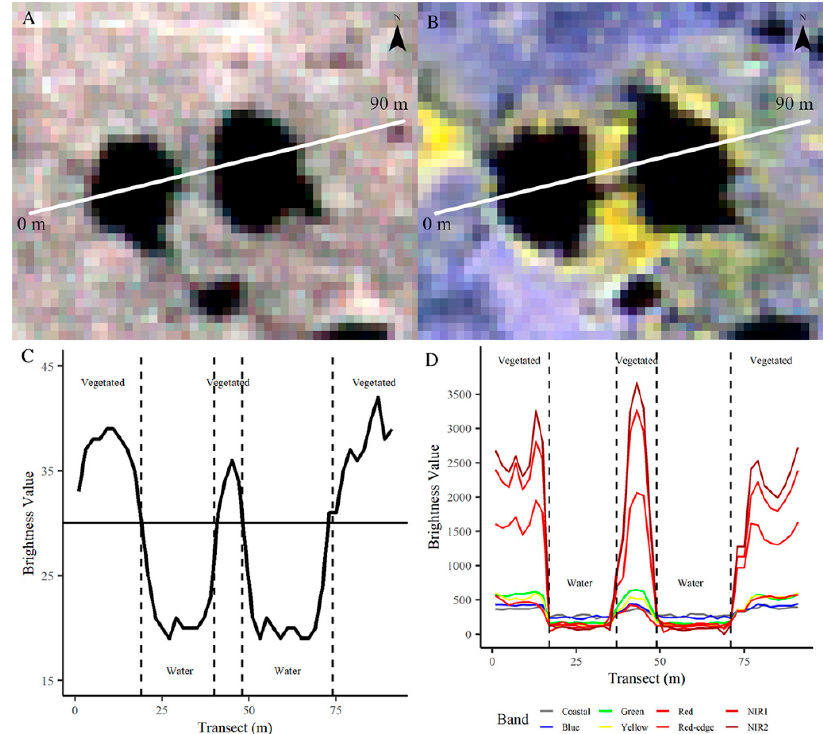
Figure 4. Arbitrary transect across ( A ) the 1940 panchromatic photograph and ( B ) 2012 WorldView-2 image showing the brightness values of the ( C ) panchromatic photograph and the ( D ) WorldView-2 imagery bands.